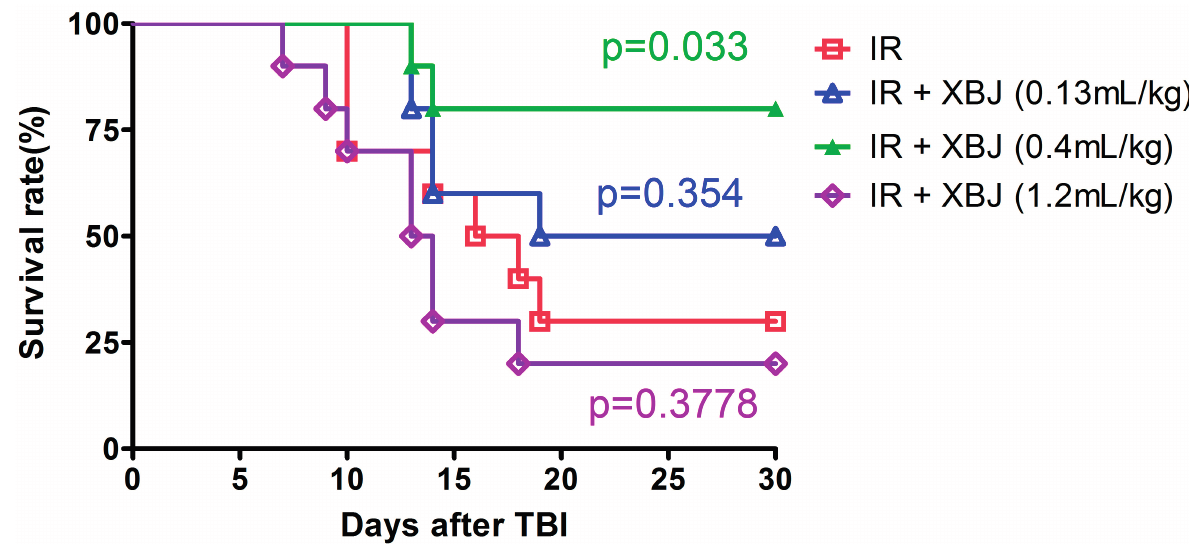
Figure 1. The survival of mice exposed to total body irradiation (TBI) (7.5 Gy) was increased by Xuebijing injection (XBJ) administration. After the mice had been exposed to 7.5 Gy TBI, the mice were treated by intraperitoneal (i.p.) injection of the vehicle as an irradiation control (IR, n = 10). XBJ was administered as described in the Experimental Section. The data are expressed as the percentage of surviving mice. The p -value indicates the significance of the difference between the mice treated with XBJ and the IR alone group and was determined by a log-rank